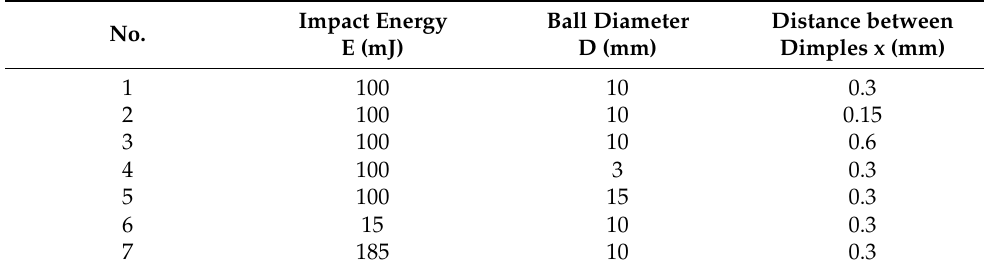
Table 5. Shot-peening